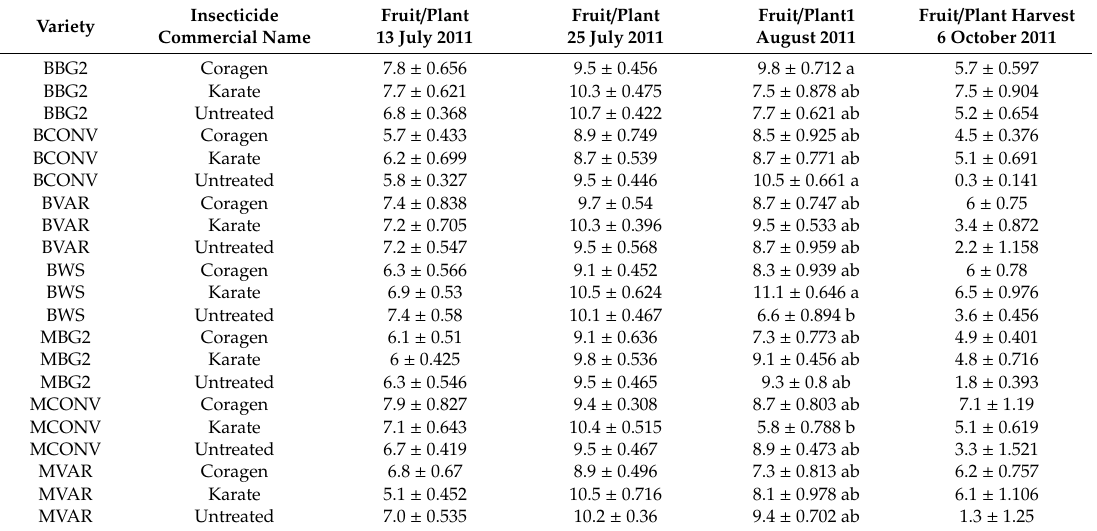
Table 6. Mean ± SEM number 1st position fruit per plant on three within-season sample dates and at harvest in 2011. Means not followed by a common letter indicate significant di ff erences between treatments based on LSD at p < 0.05.